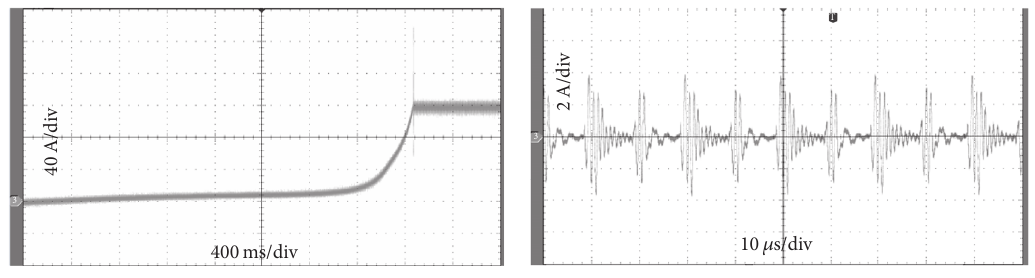
Figure 9: Experimental